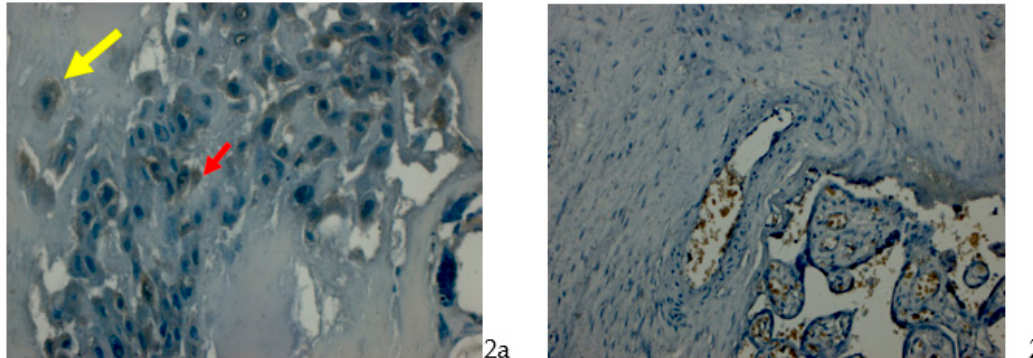
Figure 2 . ( a ) Gestational diabetes mellitus group, positive Bax protein expression in decidual cells (yellow arrow) and cytotrophoblast cells (red arrow); Bax immunohistochemistry stain, Bar 50 µm. ( b ) Gestational diabetes mellitus group, negative Bcl-2 expression in maternal and fetal faces; Bcl2 immunohistochemistry stain, Bar 100